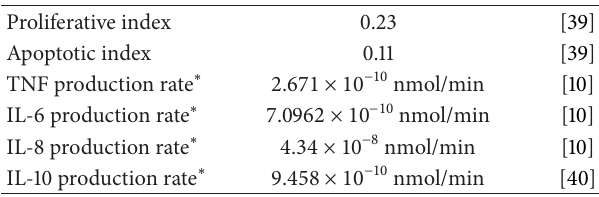
Table 3: Optimized values of parameters for MDM in vitro cultures (with reference for initial